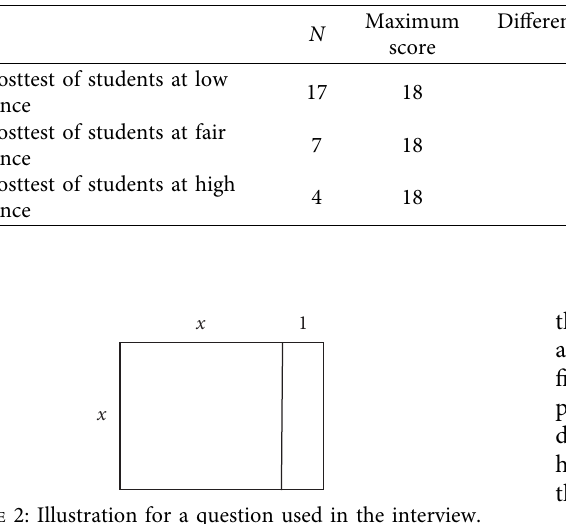
Table 9: Dependent t -test on critical thinking skills of students at all performance levels.